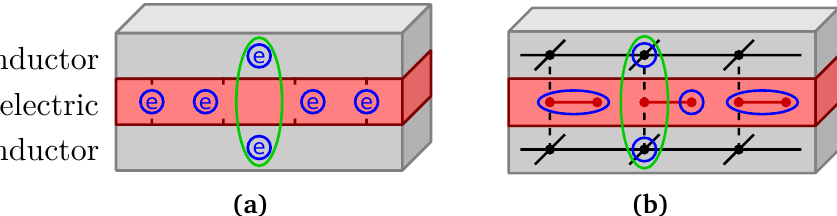
Figure 1: (a) A rough cartoon of the model that we study, which resembles an idealized conductor-dielectric-conductor trilayer. An electron on one of the conducting layers repels neighboring electrons on the dielectric, which attracts another electron on the other conducting layer; together, the two electrons form a Cooper pair (circled in green). (See Sec. 5.2 for discussion.) (b) The conductor-dielectric-conductor picture can be realized in different ways. In (b), we depict in more detail how it is realized in our toy model [ Eq. (6) ] . Each blue circle (or oval) denotes the location (or superposition of locations) of an electron for a state with a Cooper pair (circled in